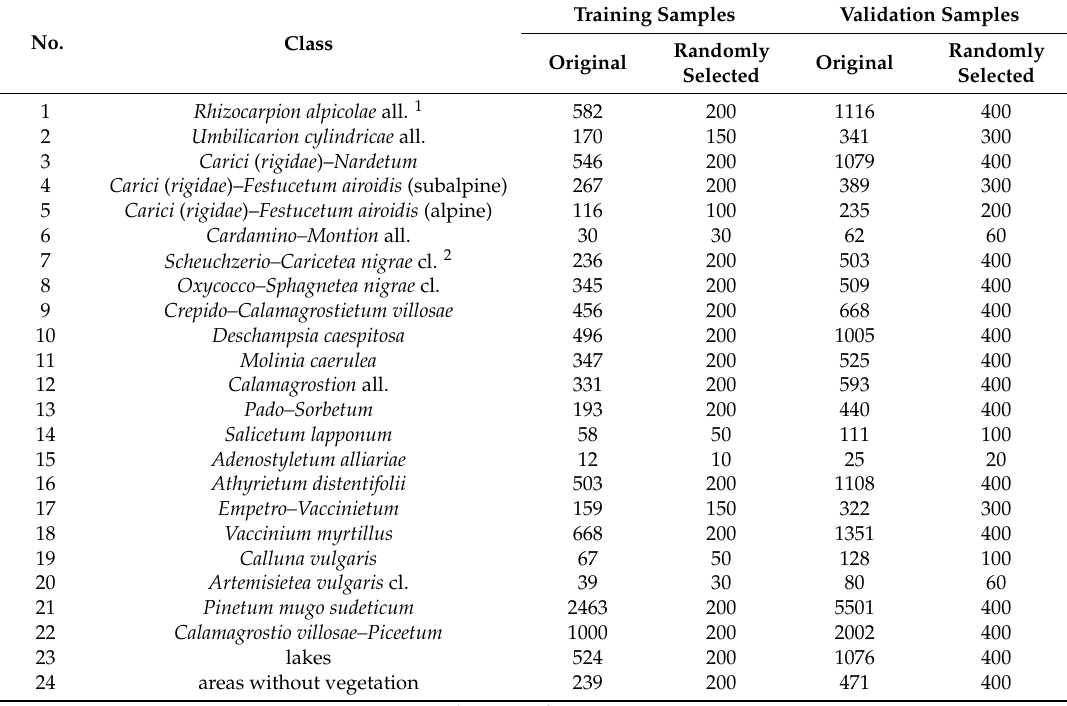
Table 1. The number of samples used for classification and